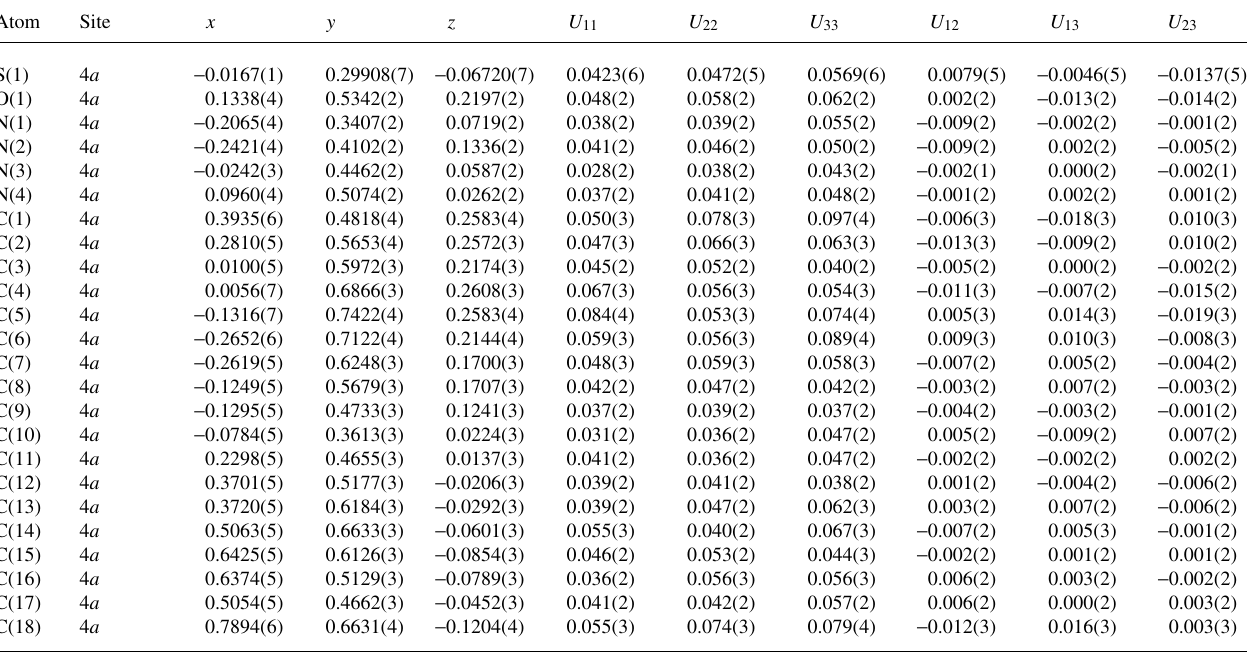
Table 3. Atomic coordinates and displacement parameters (in Å 2 )